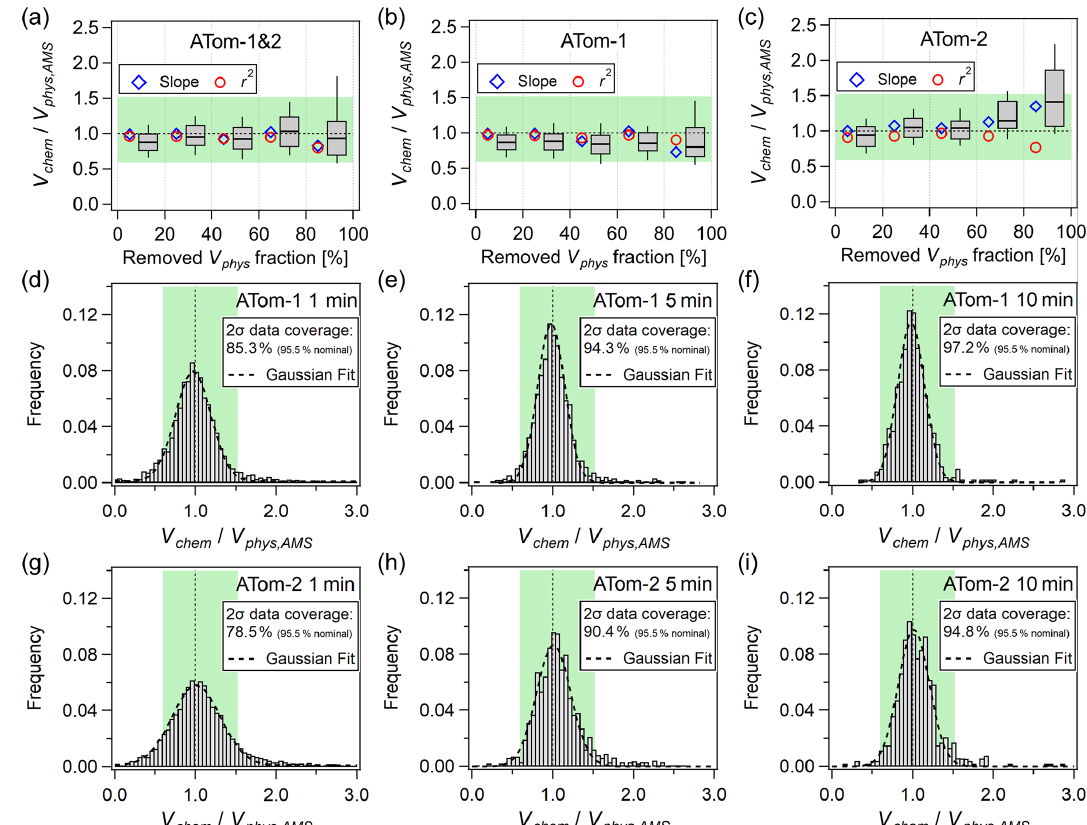
Figure 5. Box plots of V chem /V phys , AMS and the linear regression fitting slopes and correlations of the two volumes for (a) the combined ATom-1 and ATom-2 datasets, (b) ATom-1, and (c) ATom-2, binned by removed V phys fraction when applying AMS transmission (at 20% interval). The 10th, 25th, 50th, 75th, and 90th percentiles are plotted with the box and whiskers. The binned scatter plots can be found in the Supplement in Fig. S33. Panels (d–i) are the normalized frequency distributions of the volume ratio for ATom-1 and ATom-2, respectively, at three averaging timescales: (a, d, g) 1min, (b, e, h) 5min, and (c, f, i) 10min. The green-tinted backgrounds indicate the combined 2 σ accuracy from AMS (38%; 2 σ ) (Bahreini et al., 2009) and UHSAS ( + 12 . 4% / − 27 . 5%; treated as 1.5 σ in this study) (Kupc et al.,